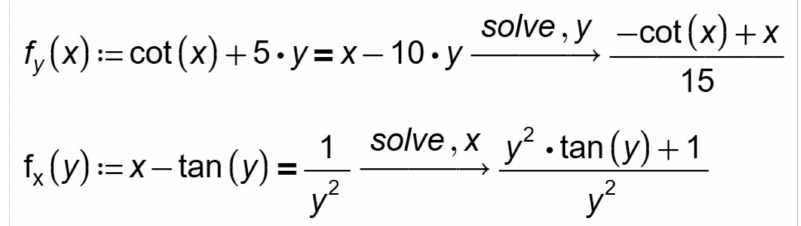
Figure 6. Code of the Mathcad program for the solution with respect to one